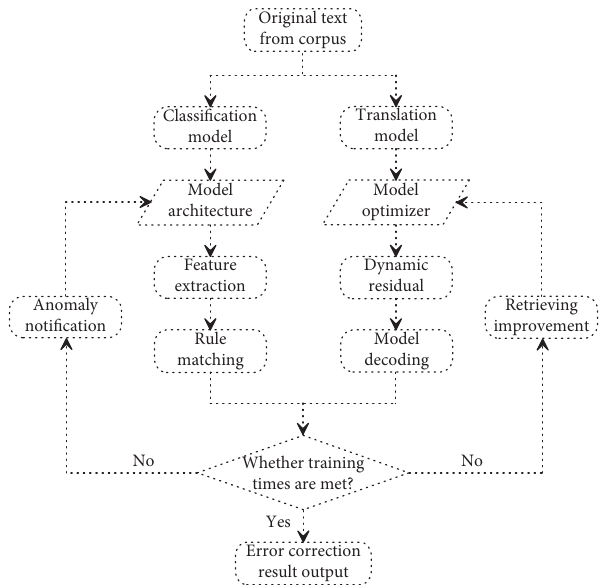
Figure 3: Flowchart of English grammar error correction algo- rithm based on classification